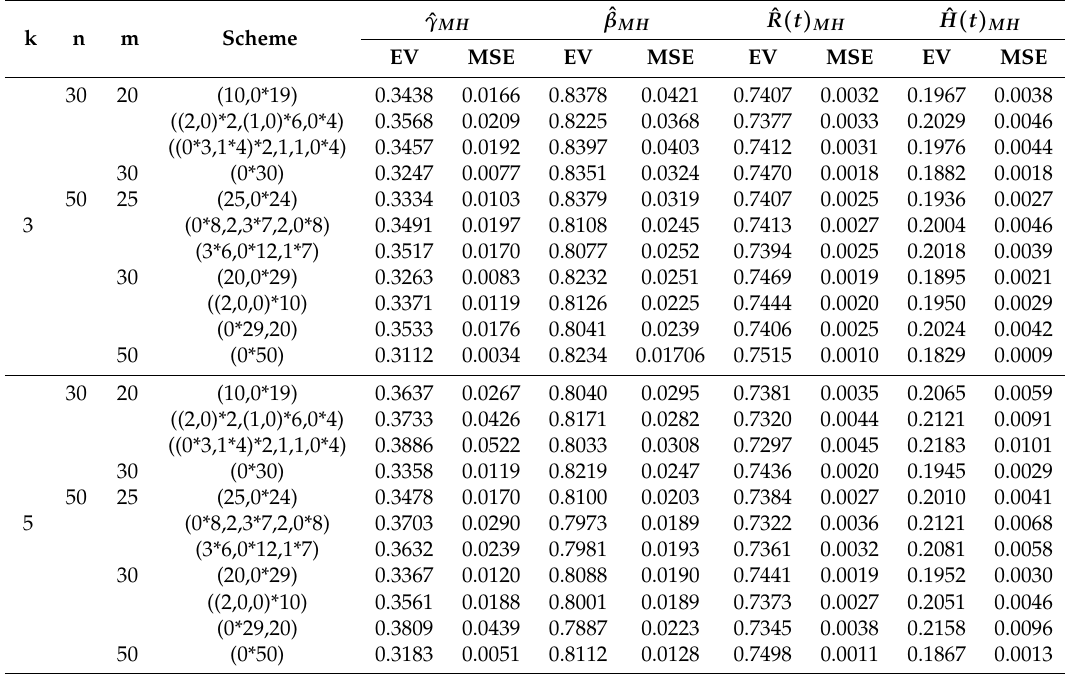
Table 16. Estimation values and MSEs of parameters, reliability and hazard functions using Metropolis-Hastings method under GELF when q = − 0.5, γ = 0.3, β = 0.8, t = 1.5, a 1 = 1.08,